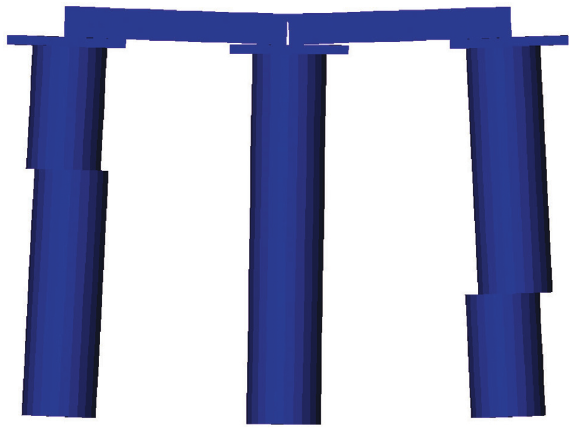
Figure 10: Deformed shape of the